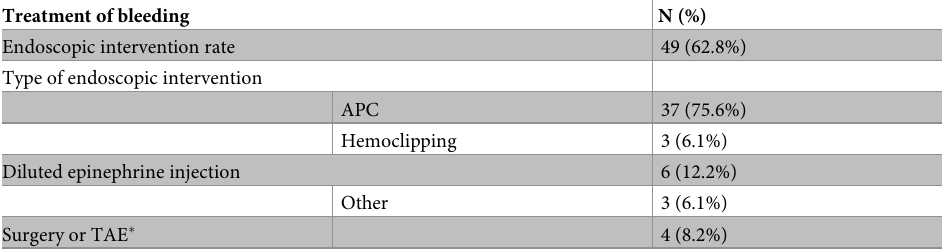
� Three patients underwent segmental bowel resection and one patient underwent TAE APC: argon plasma coagulation; OGIB: obscure gastrointestinal bleeding; TAE: transcatheter arterial